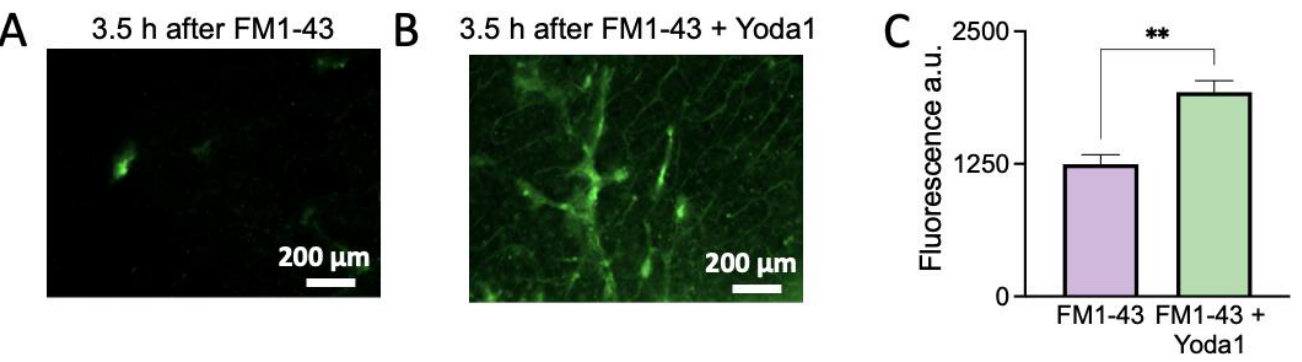
Figure 4. FM1-43 highlights previous Yoda1-induced Piezo1 activation in mouse ex vivo meninges. ( A ). Microphotographs demonstrating the fluorescence of meninges after 10 min of staining with only FM1-43 treatment as a control, followed by 3.5 h of washout. Few membranes are stained and visible. ( B ). Microphotographs demonstrating the fluorescence of meninges after 10 min if staining with FM1-43 + Yoda1, followed by 3.5 h of washout. Many meningeal structures are labelled. ( C ). Fluorescence of a whole imaged region was 1247 ± 90.2 a.u. in control (FM1-43) vs. 1925 ± 108.1 in FM1-43 + Yoda1 treated samples ( n = 7, paired t-test, ** p = 0.002).